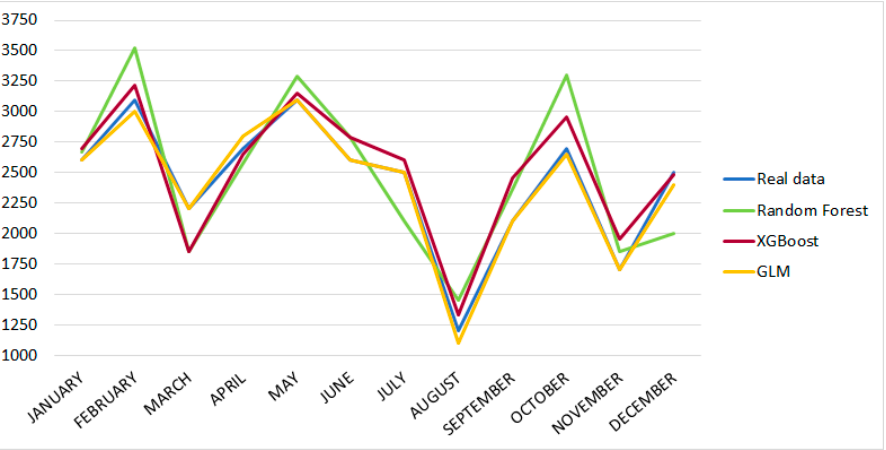
Figure 11. Comparison of the predictions de los modelos GLM, xgbost y random forest of the weekdays with respect to the actual data of 2018.